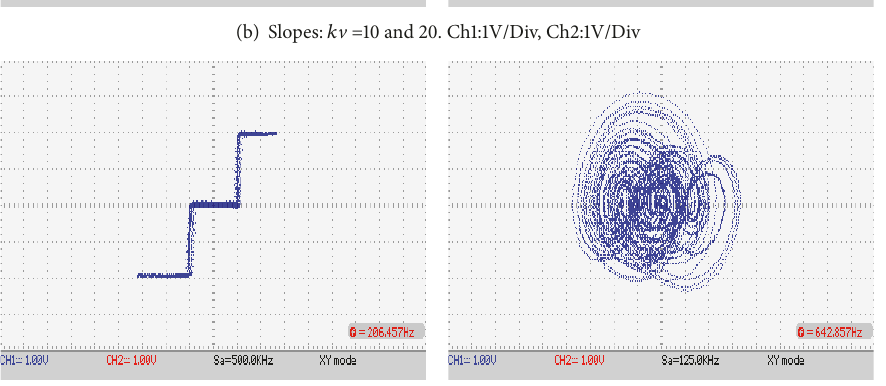
(b) Slopes: 𝑘 V =10 and 20. Ch1:1V/Div, Ch2:1V/Div